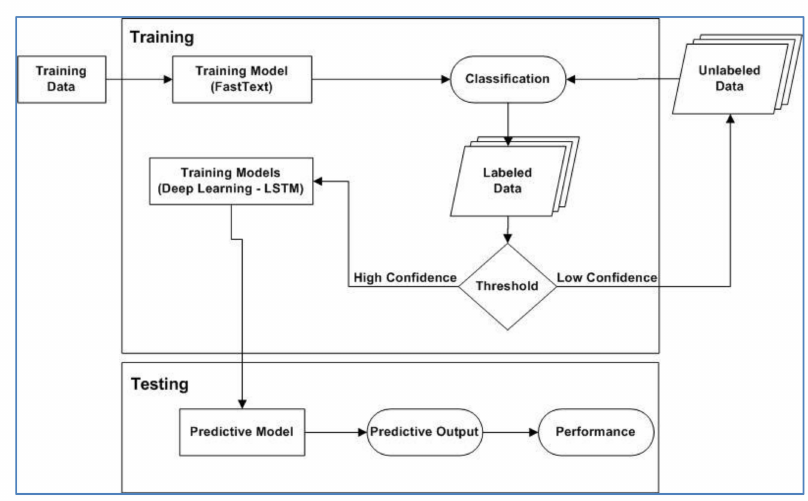
Figure 4. Automatic Emotion Annotation.